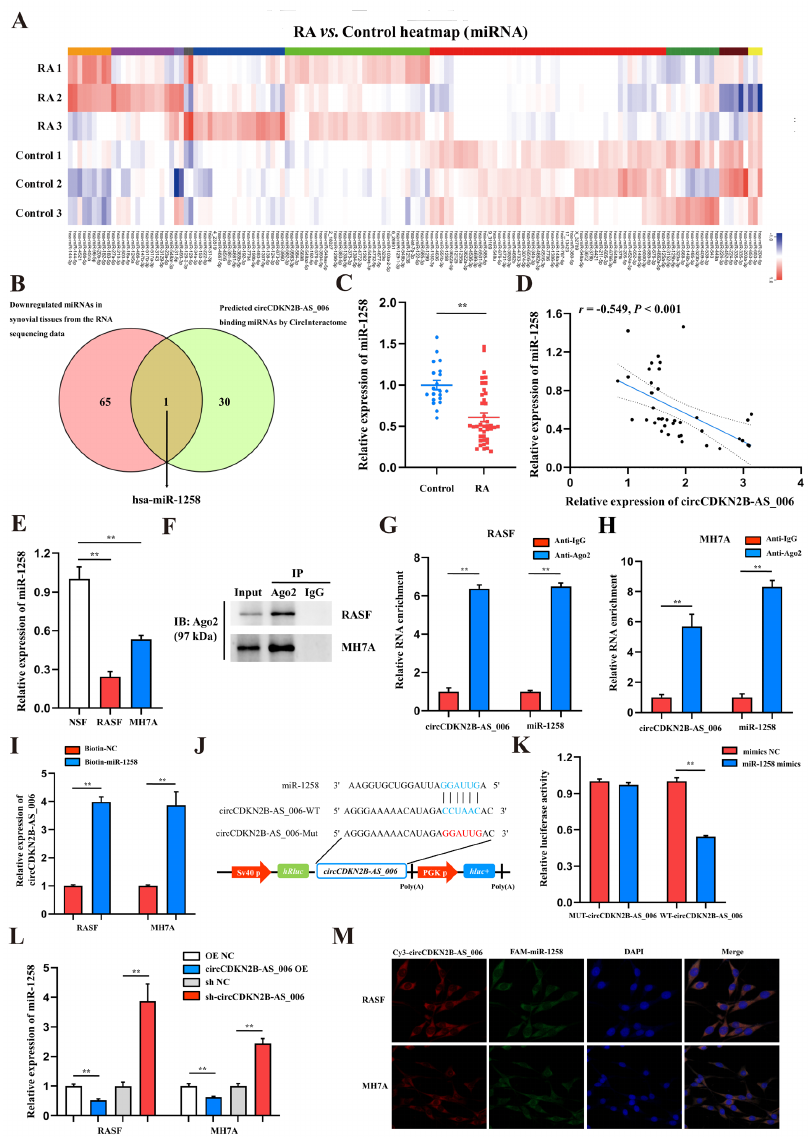
Figure 3. CircCDKN2B−AS_006 serves as a sponge for miR−1258. ( A ) Heatmap of differentially ex- pressed miRNAs in two groups. ( B ) Venn diagram showing the overlapping of the target miRNAs of circCDKN2B−AS_006 predicted based on the circular RNA interactome and the results of whole−transcriptome sequencing (downregulated miRNAs). ( C ) The relative expression of miR−1258 was detected in the synovia from RA patients ( n = 40) and non−RA patients ( n = 16) via RT−qPCR. ( D ) Correlation analysis between circCDKN2B−AS_006 and miR−1258 expression in the synovia from RA patients. ( E ) RT − qPCR analysis of the relative expression levels of miR − 1258 in RASFs, MH7A cells, and NSFs. ( F – H ) RIP with an anti − AGO2 antibody in RASFs and MH7A cells was used to detect the circCDKN2B − AS_006 and miR − 1258 mRNA levels. ( I ) RNA pull − down was executed in RASFs and MH7A cells, followed by RT − qPCR to detect the enrichment of circCDKN2B − AS_006. ( J ) A schematic of the wild − type (WT) and mutant (MUT) circCDKN2B − AS_006 luciferase reporter vectors. ( K ) The luciferase activities of the circCDKN2B − AS_006 luciferase reporter vector (WT or MUT) in 293T cells transfected with miR − 1258 mimics or NC mimics. ( L ) The expression of miR − 1258 in RASFs and MH7A cells after knocking down and overexpressing circCDKN2B − AS_006. ( M ) FISH results, showing the colocalization of circCDKN2B − AS_006 and miR − 1258 in RASFs and MH7A cells. ** p <